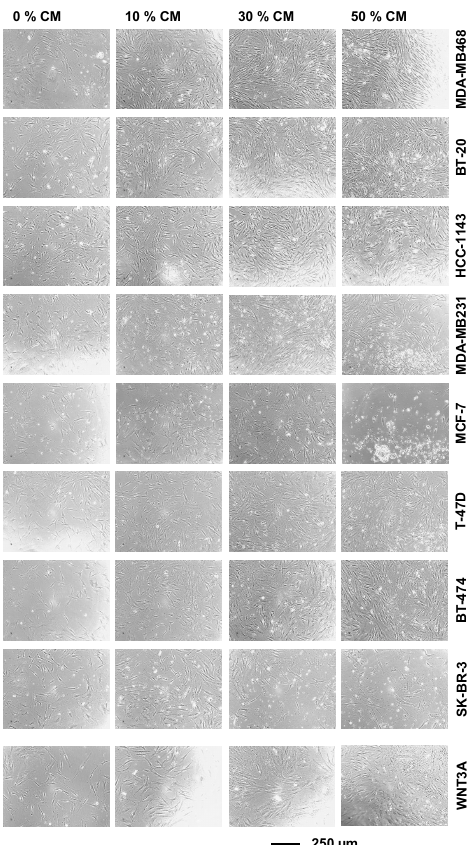
Figure A1. Breast cancer cell line CM and WNT3a CM potentiate BAF proliferation. Microscopic images of representative wells from an experiment subsequently used for the proliferation assay (for details see legend to Figure 1B,C).